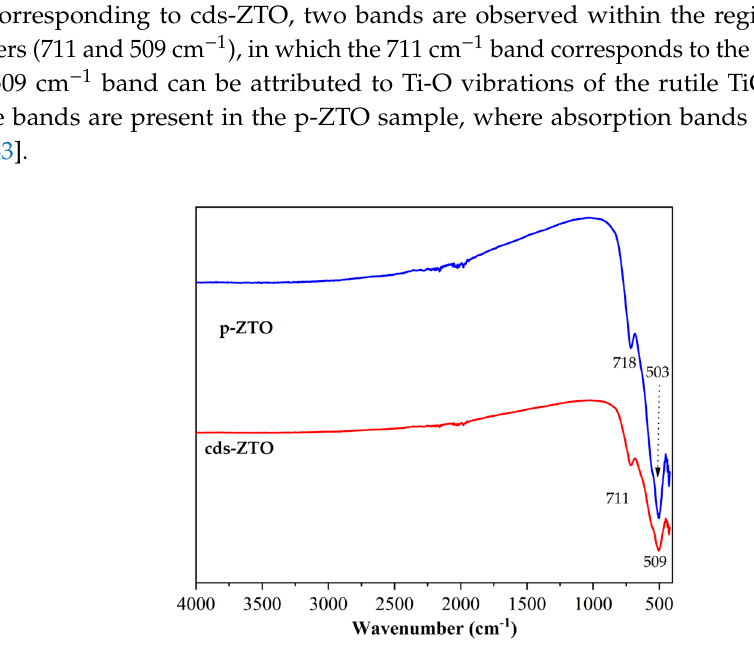
Table 2. Specific surface area comparison between cds-ZTO and p-ZnTiO 3 with respect to other zinc titanates obtained by di ff erent calcination temperatures and synthesis methods.